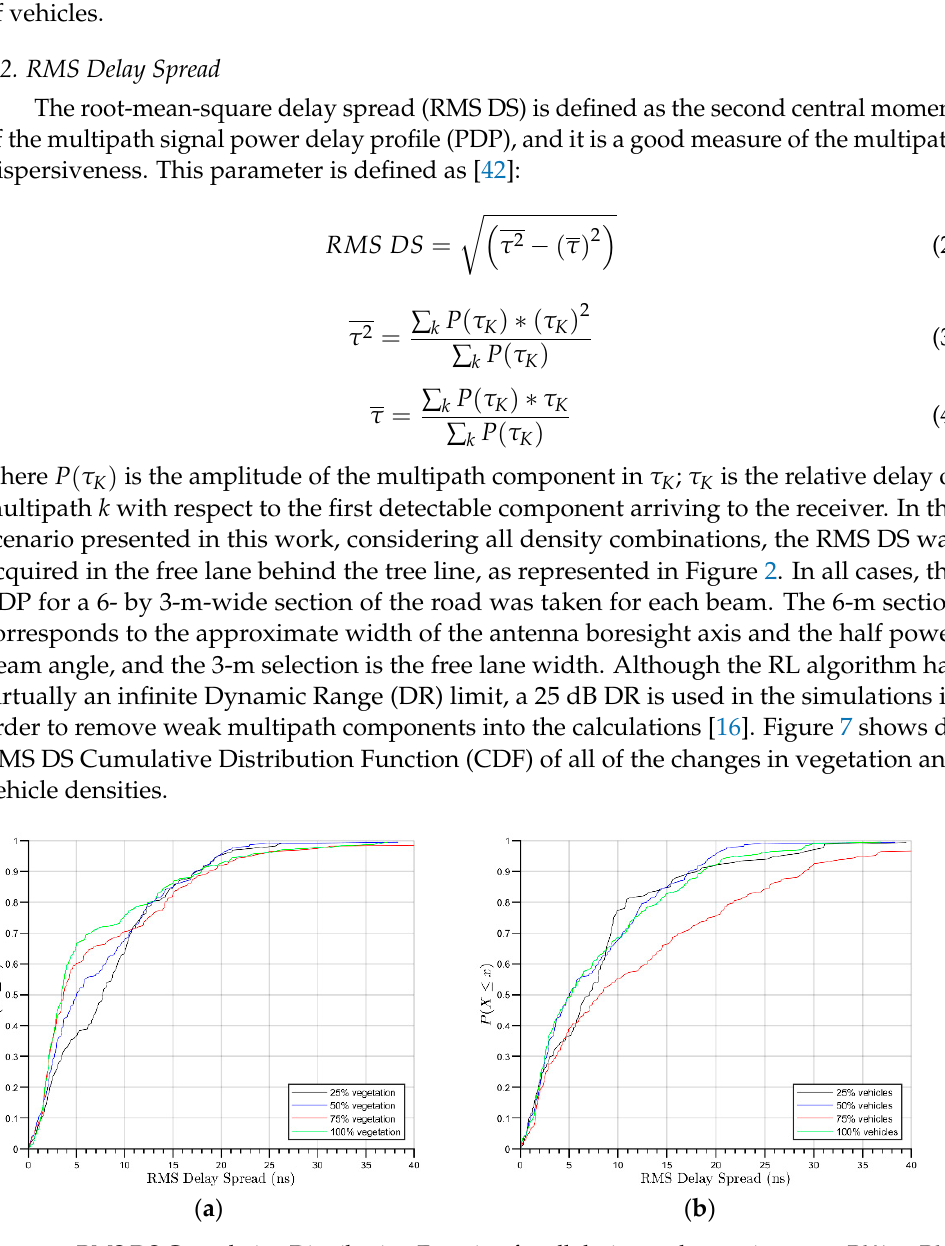
Figure 7. RMS DS Cumulative Distribution Function for all designated reception areas RX1 to RX5 (see Figure 2 for refer- ence): ( a ) different vegetation densities; ( b ) different vehicle